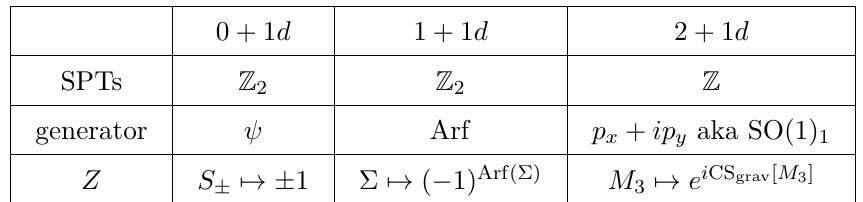
denotes ± R = 1 tr ( ω d ω + 2 1 ω 3 ) . grav 4 π 48 3 M 3